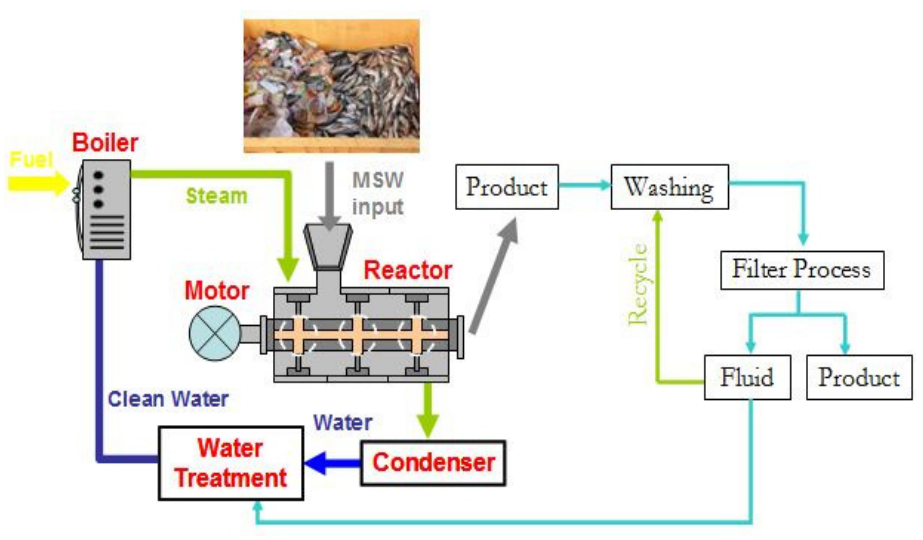
Figure 1. Water washing process combined with the hydrothermal